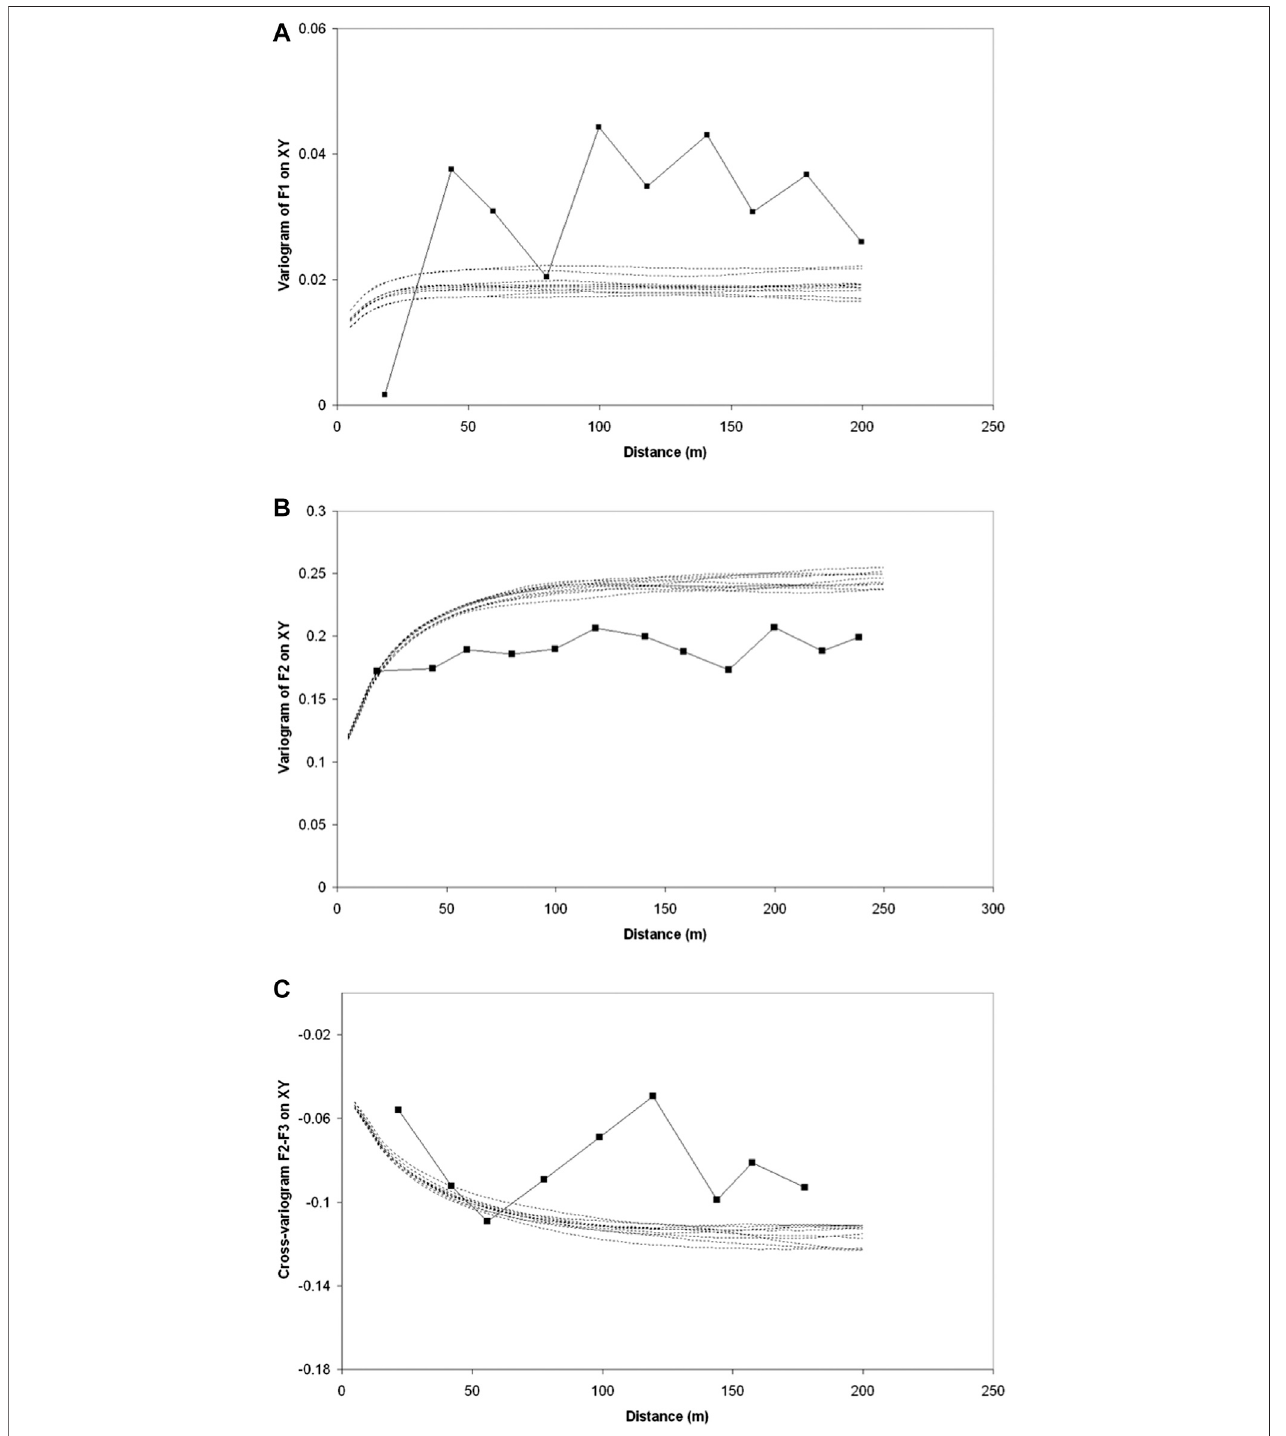
FIGURE 12 | Variogram of the borehole (solid line) data and from the simulations (dashed lane) calculated along the horizontal direction. (A) Variogram of hydrofacies F1. (B) Variogram of hydrofacies F2 and (C) cross-variogram of hydrofacies F2 and F3.